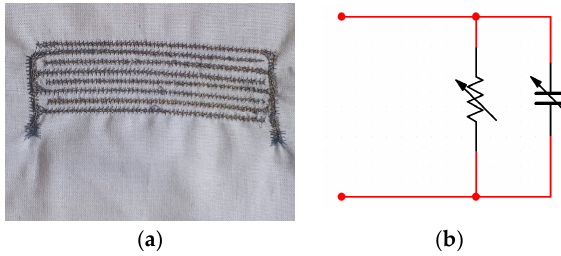
Table 2. Measured sensors module impedances ranges at 2 kHz. Figure 7. Proposed long sensor: ( a ) physical implementation and ( b ) electrical model .